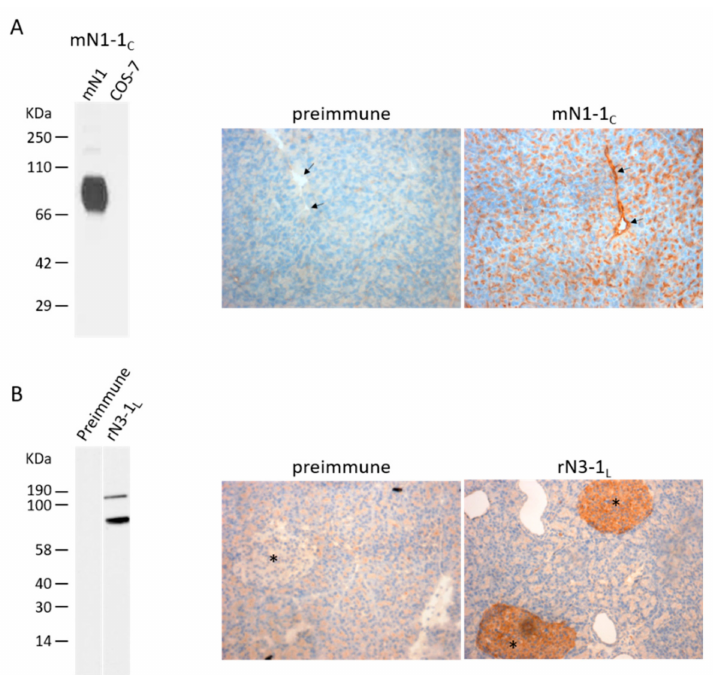
Figure 3. Specificity of the guinea pig anti-mouse NTPDase1 antibody mN1-1 c ( A ) and of the rabbit anti-rat NTPDase3 antibody rN3-1 L ( B ) analyzed by immunoblot (left panels) or by immunohistochemistry (right panels). A) Immunoblot of lysates from COS-7 cells transfected with plasmids encoding mouse NTPDase1 (mN1) or from untransfected COS-7 cells (COS-7). A strong reaction is observed in the transfected cell lysate only. Right panel shows immunohistochemical staining of a mouse pancreas section incubated with the antiserum mN1-1 c or with the pre-immune serum. The antiserum displays a strong positive reaction on blood vessels shown by arrows and on zymogen granules in pancreatic acinar cells. ( B ) Immunoblot of lysates from COS-7 cells transfected with plasmids encoding rat NTPDase3 incubated with the antiserum rN3-1 l or with its pre-immune serum shows a strong reaction only with the antiserum. NTPDase3 is detected as both a monomer and a dimer. Right panels show immunohistochemical staining of rat pancreas sections incubated with the antiserum or the pre-immune serum. The antiserum displays a positive reaction on Langerhans islet cells which are indicated by a star. Nuclei were stained in blue with hematoxylin in immunohistochemistry. The antisera were diluted 1:500 except for mN1-1 c in the immunoblot ( A ) that was diluted